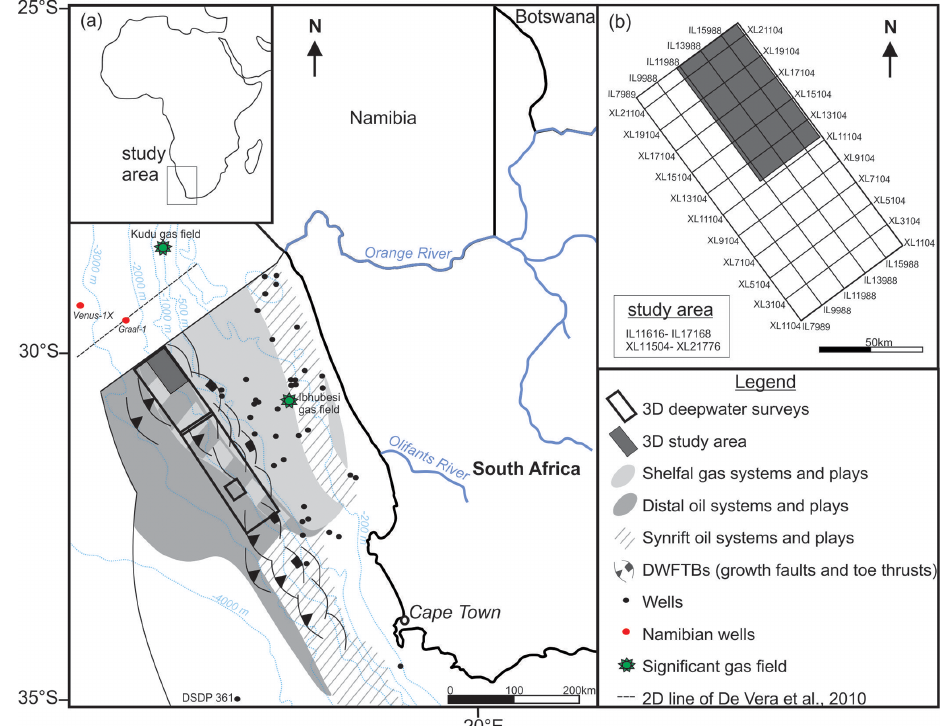
Figure 2. Simplified map of the Orange Basin study area offshore of the SW African coastline. (a) Known and predicted petroleum systems and plays and the position of gravitational structures and wells within the South African licensing area (adapted from Jungslager, 1999). (b) Location of the present study within the full 3D seismic